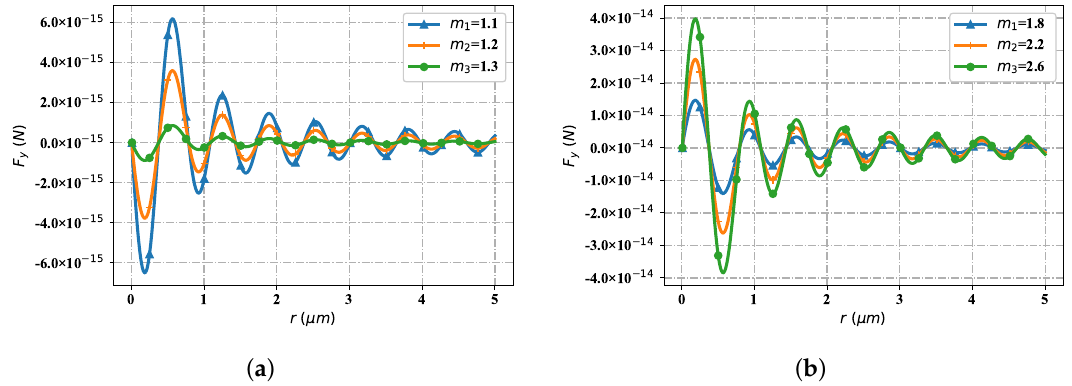
Figure 13. The distribution of F y under different refractive indices,including the lower indices and upper indices (comparing to the surrounding index). ( a ) F y with low indices; ( b ) F y with high indices. Figure 14 contains the change of particle refractive index, but the spatial distribution trend of the optical radiation force component F z . Similarly, consider two cases: the particle refractive index is less than the environment refractive index and the particle refractive index is greater than the environment refractive index. As shown in Figure 14a (the particle refractive index is smaller than the environmental refractive index), at the first stagnation point, the particle F z values of different refractive indexes are all zero. At the first wave crest, when the particle refractive index is 1.1, the F z value is smaller than the corresponding F z value when the particle refractive index is 1.2; The F z value when the particle refractive index is 1.2 is smaller than the corresponding F z value when the particle refractive index is 1.3. All F z values at the second and subsequent stagnation points tend to zero. At the second wave crest, the distribution trend of F z values corresponding to particles with different refractive index is similar to that at the first wave crest, but the overall F z values are smaller than those of particles at the first wave crest. At the third and subsequent wave peaks, the distribution trend of F z values of particles with different refractive indexes is similar to that at the second wave peak, but the overall values gradually decrease. As shown in Figure 14b (the particle refractive index is greater than the environmental refractive index), the change trend of F z values corresponding to particles with different refractive index is similar to that in Figure 14a, but the overall F z value is one order of magnitude higher. At the stagnation point, the F z values corresponding to different particle refractive indices tend to zero; At the wave crest, the corresponding F z value gradually increases with the increase of the particle refractive index value; The further it moves back, the smaller the F